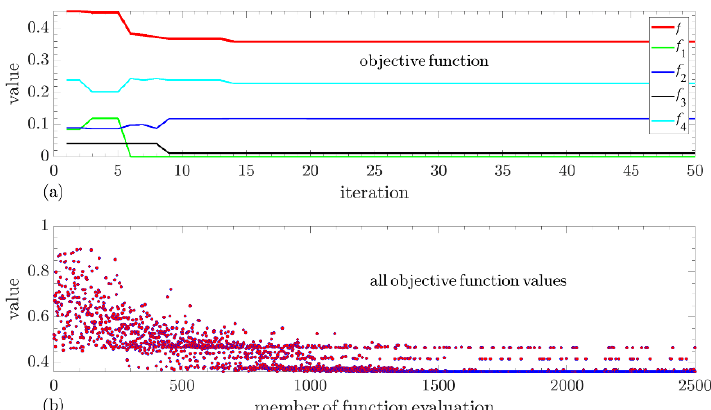
Figure 12. The results of all objective functions and all objective function values for large substation: ( a ) Results of all objective functions; ( b ) Results of all values of the objective functions.